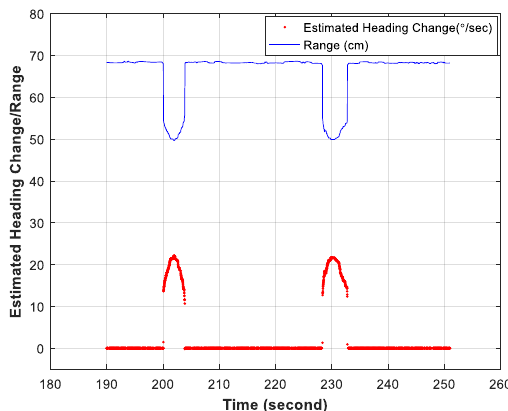
Figure 9. Ultrasonic sensor range versus the change of heading along with the linear regression model for the left turn category of the second data set.